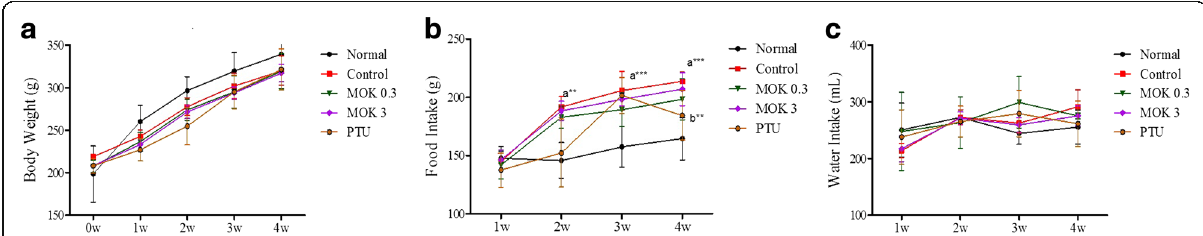
Fig. 2 Effects of MOK pharmacopuncture on the changes of physiological parameters in LT4-induced hyperthyroidism rats. MOK pharmacopuncture was subcutaneously administered once daily for 2 weeks, and measured the body weight ( a ), and food and ( b ) and water ( b ) intake once a week. Data are presented as mean±SD ( n =5 per each group). * P <0.05, ** P <0.01 and *** P <0.001 vs normal ( a ) or control ( b ). Normal, normal group; Control, LT4-induced hyperthyroidism group; MOK 0.3, MOK 0.3 mg/kg-treated group in control; MOK 3, MOK 3 mg/kg-treated group in control; and PTU, PTU 10 mg/kg-treated group as a reference